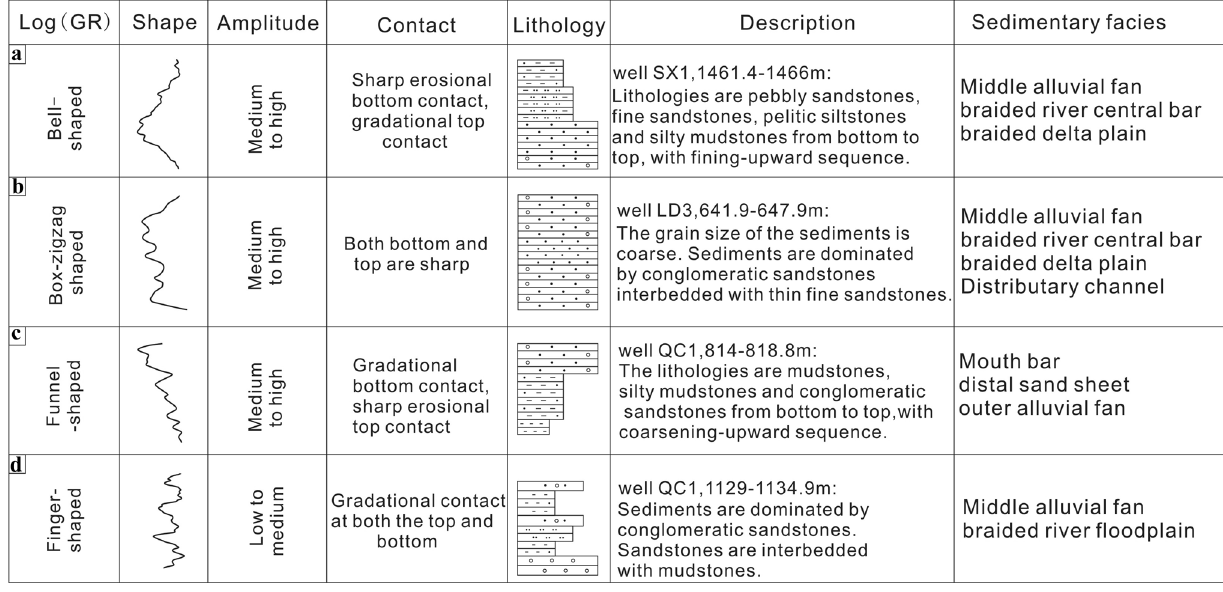
Fig. 7 Typical sedimentary log through the Oligocene Xiaganchai- gou Formation (E 3 ) showing the distribution of major sedimentary facies and depositional environments. Characteristics, lithology and